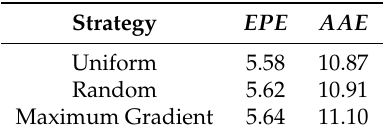
Table 14. Summary of the obtained results for different strategies.